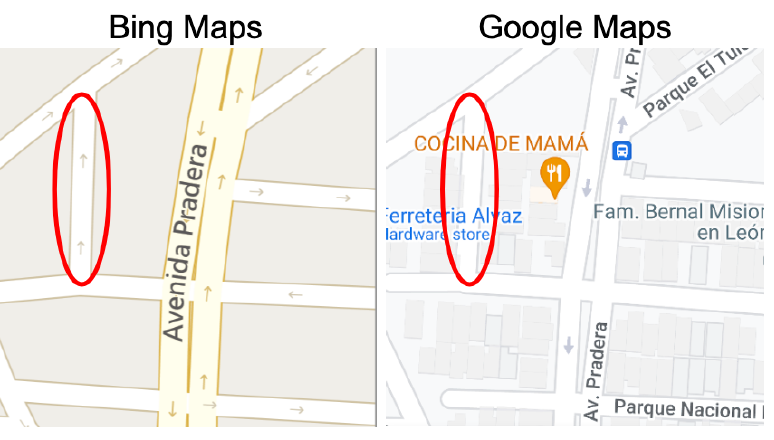
Figure 24. Type 1 (weak discrepancy) example-Mexico.